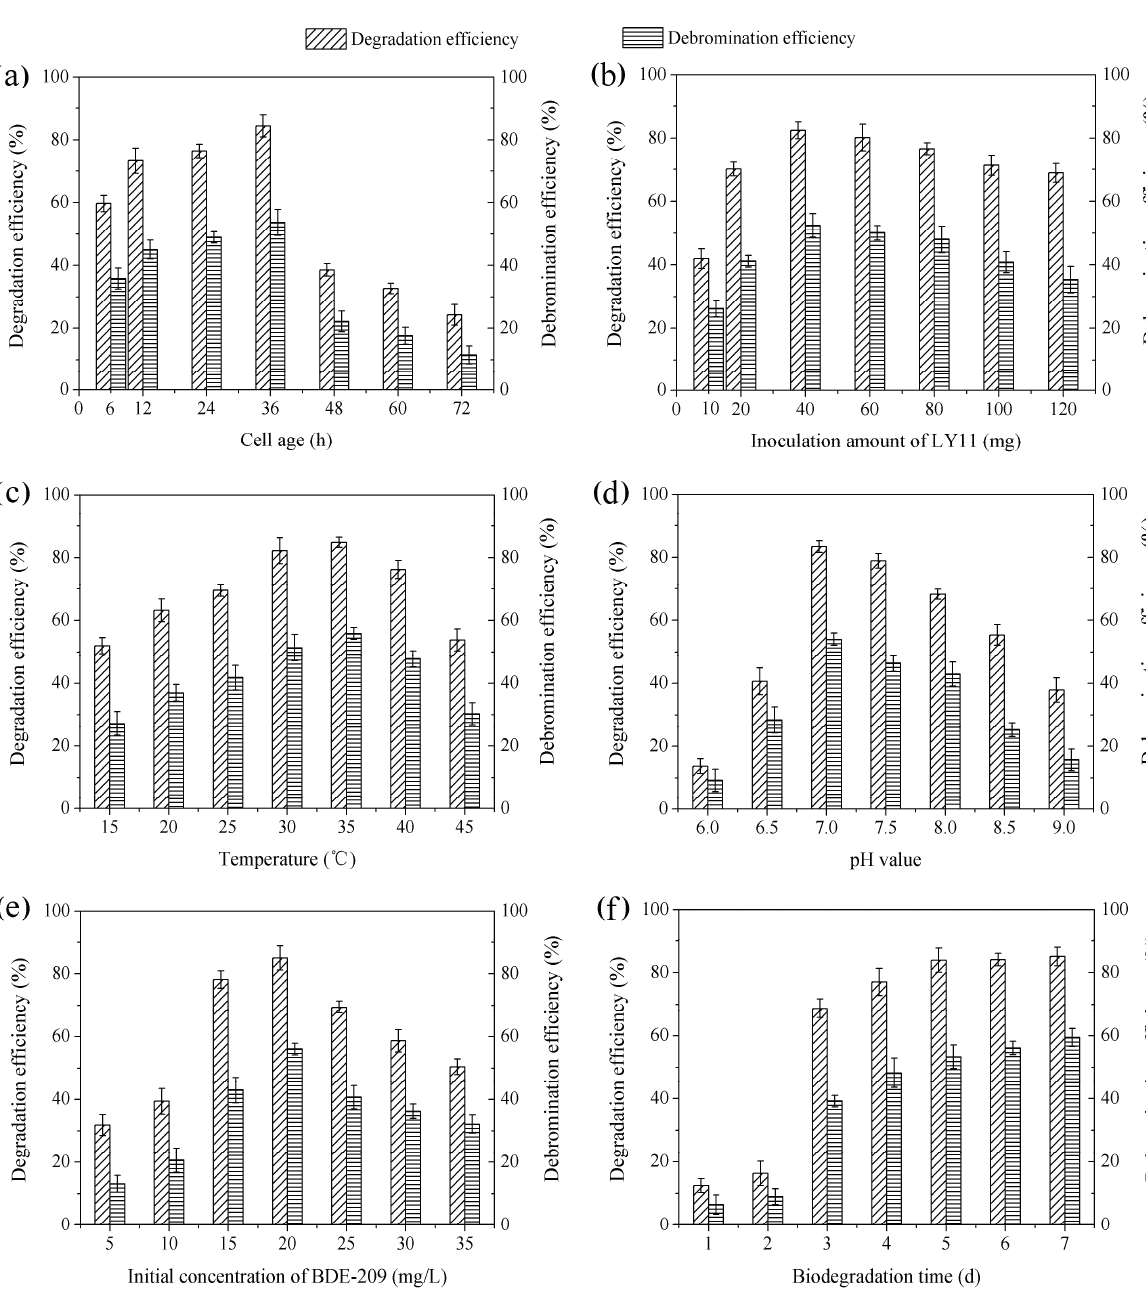
Figure 3. Degradation efficiency and debromination efficiency of BDE-209 by LY11 under different conditions. ( a ) Cell age was set at 6–72 h, other conditions were set at LY11 40 mg, 35 °C, pH 7.0, BDE-209 20 mg/L and 5 d; ( b ) Inoculation amount of LY11 was set at 10–120 mg, other conditions were set at age 36 h, 35 °C, pH 7.0, BDE-209 20 mg/L and 5 d; ( c ) Temperature was set at 15–45 °C, other conditions were set at age 36 h, LY11 40 mg, pH 7.0, BDE-209 20 mg/L and 5 d; ( d ) pH value was set at 6.0–9.0, other conditions were set at age 36 h, LY11 40 mg, 35 °C, BDE-209 20 mg/L and 5 d; ( e ) Initial concentration of BDE-209 was set at 5–35 mg/L, other conditions were set at age 36 h, LY11 40 mg, 35 °C, pH 7.0, and 5 d; ( f ) Biodegradation time was set at 1–7 d, other conditions were set at age 36 h, LY11 40 mg, 35 °C, pH 7.0 and BDE-209 20